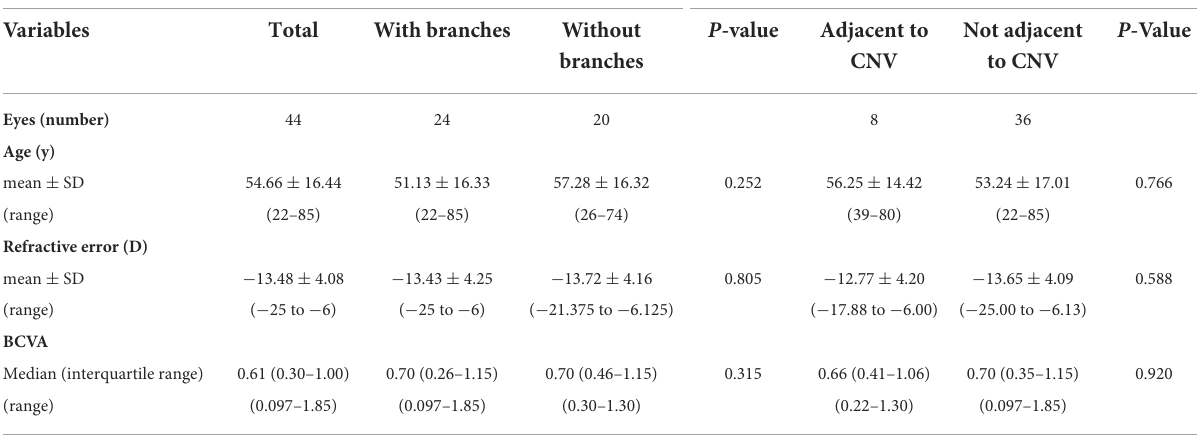
TABLE 1 Clinical characteristics of the eyes with choroidal neovascularization secondary to pathological